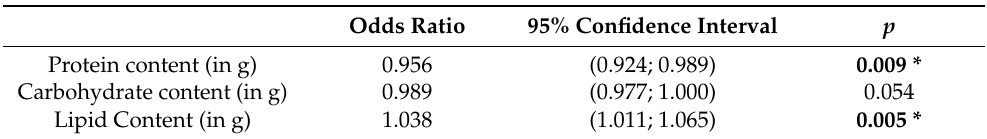
Table 2. Energy-adjusted logistic regression models for the evaluation of protein, carbohydrate, and lipid content on children’s weight status. Odds Ratio 95% Confidence Interval Protein content (in g)